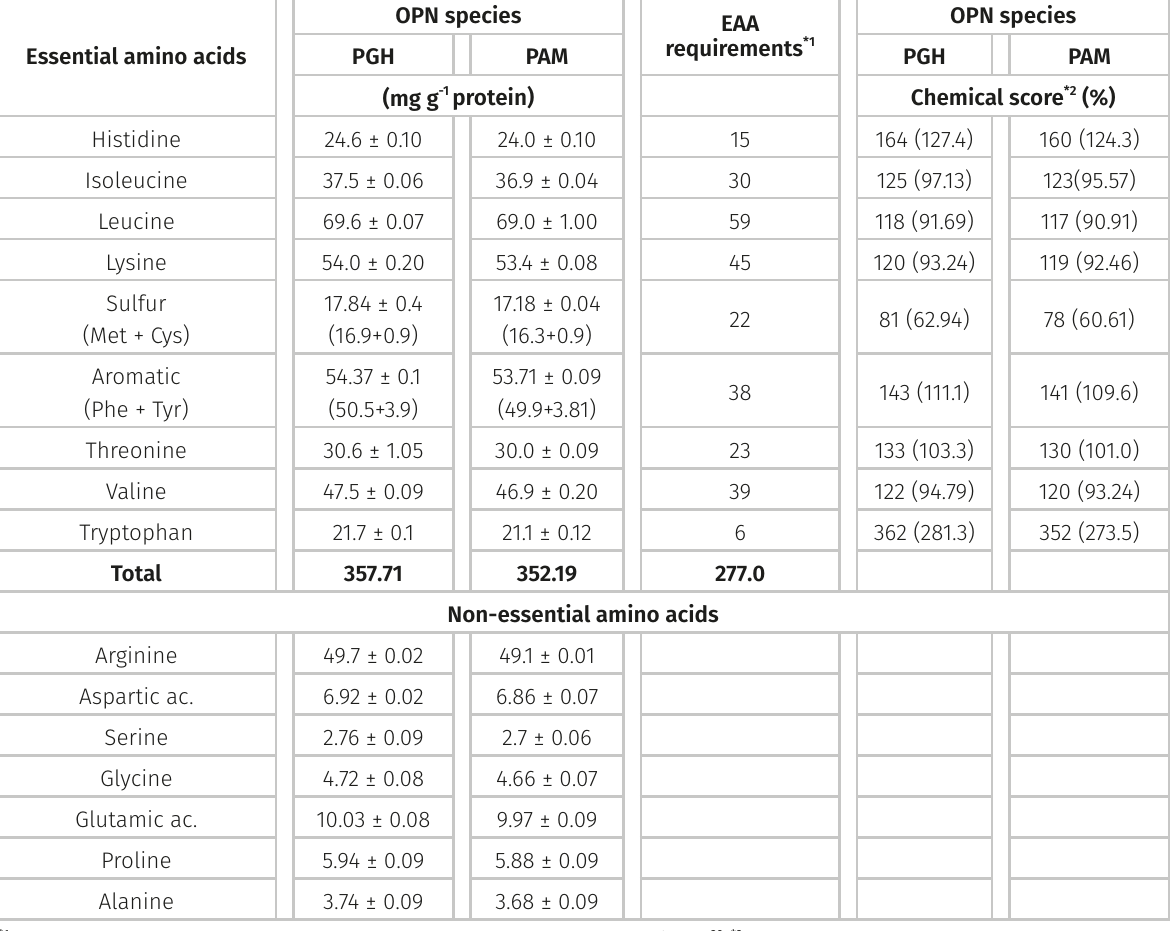
*1 Essential amino acids required by adults - current estimates by the FAO/WHO 20 . *2 Chemical score of essential amino acids, corrected for true protein digestibility